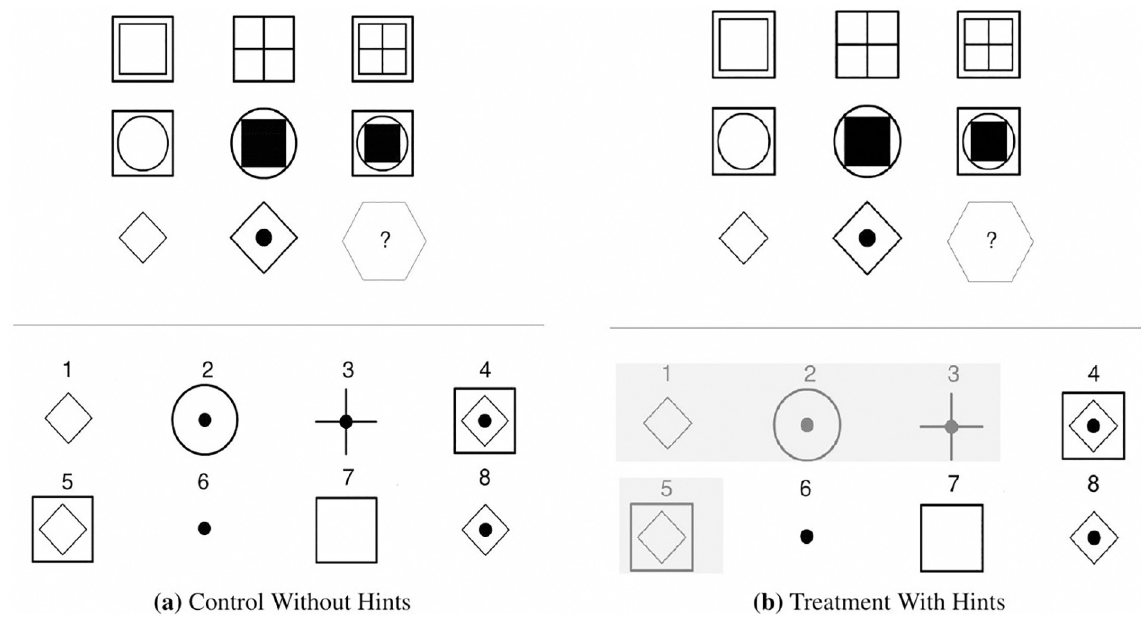
Fig 2. An example question from the task of Raven’s